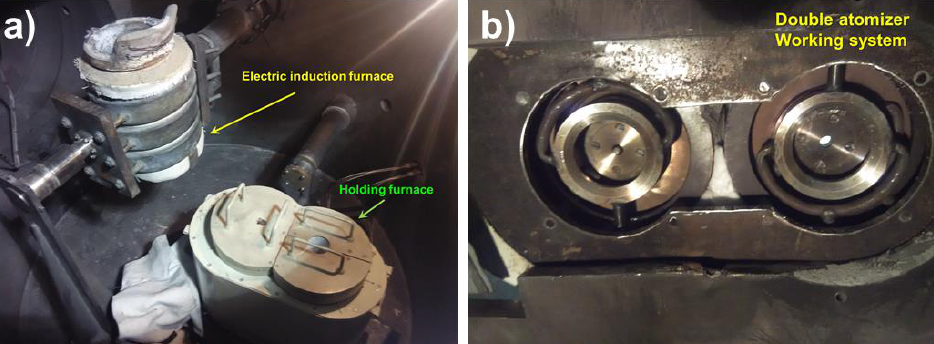
Figure 2. Modified test equipment for co-spray forming: ( a ) Smelting and insulation equipment, ( b ) double atomizer working system.